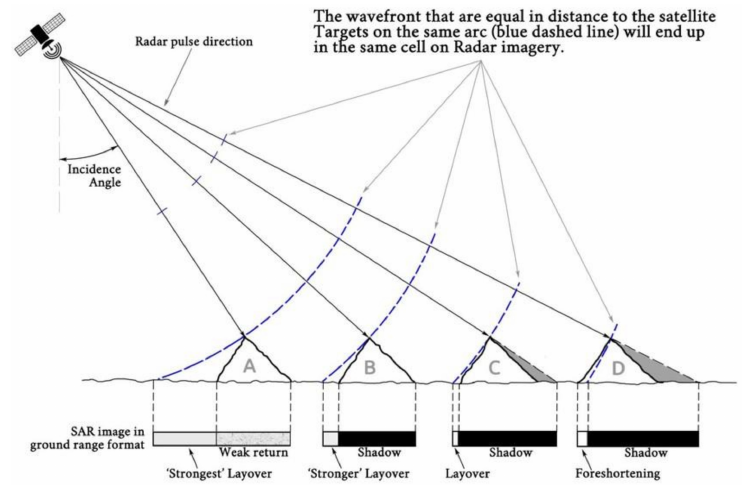
Figure 13. The effect of terrain on SAR images by geometric distortion